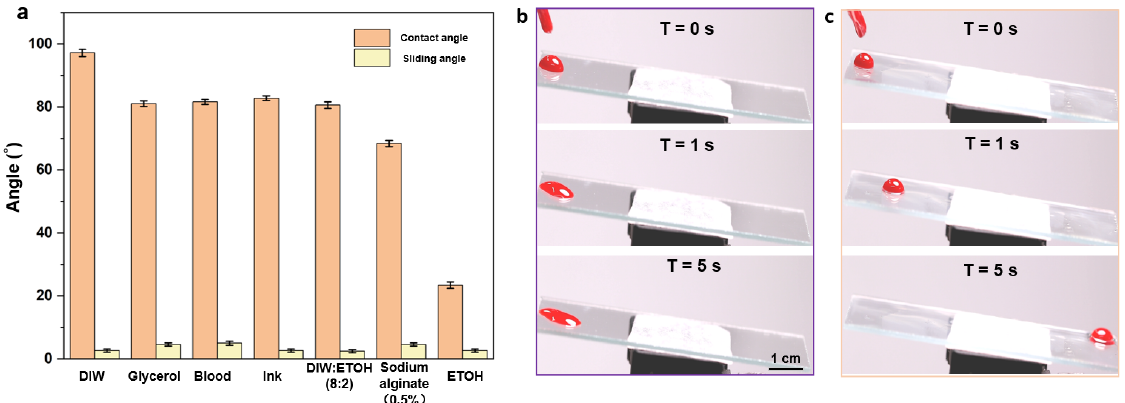
Figure 5. ( a ) Contact and slip angles of different droplets on the surface of a wet porous membrane; ( b , c ) sequential photographs of blood droplets (volume10 μ L) on bare glass ( b ) and the glass with dealt porous film ( c ) at a tilt angle of 5°.